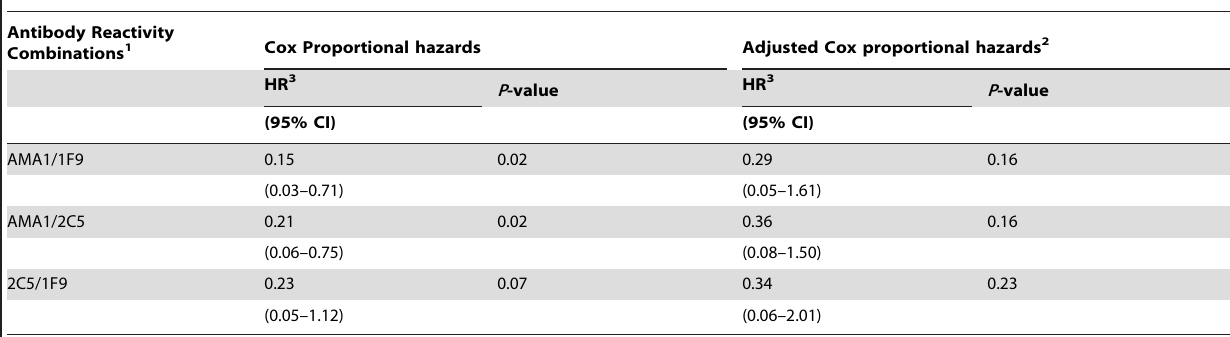
Table 2. Combined antibody responses to AMA1 and the risk of clinical malaria in the Chonyi cohort.